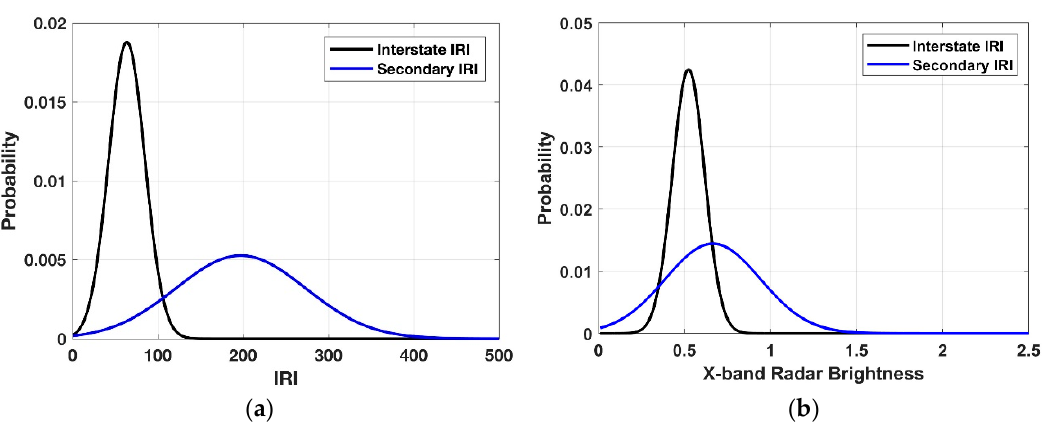
Figure 3. ( a ) Statistical distribution of IRI values for interstates (black) and secondary roads (blue) for our study area; ( b ) statistical distribution of radar brightness values by same road types.